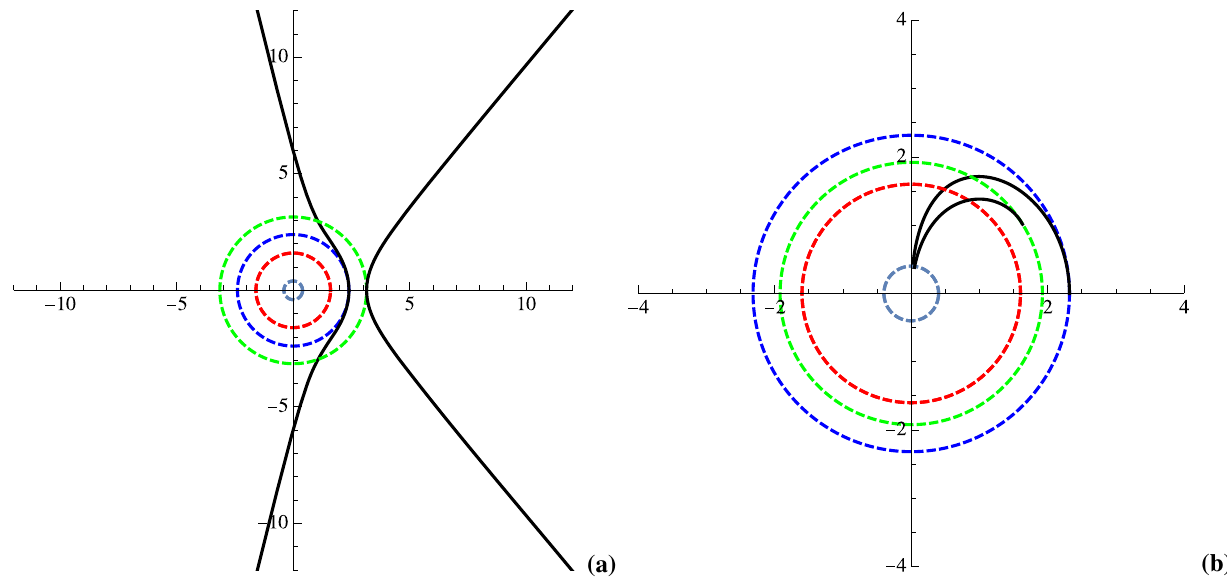
Fig. 3 The polar plots of r (γ) , respecting (a) DFKs and (b) DSKs, plotted for ω 0 = 0 . 755 (blue circles), and ω 0 = 0 . 70 (green circles). The two inner circles indicate r + and r −